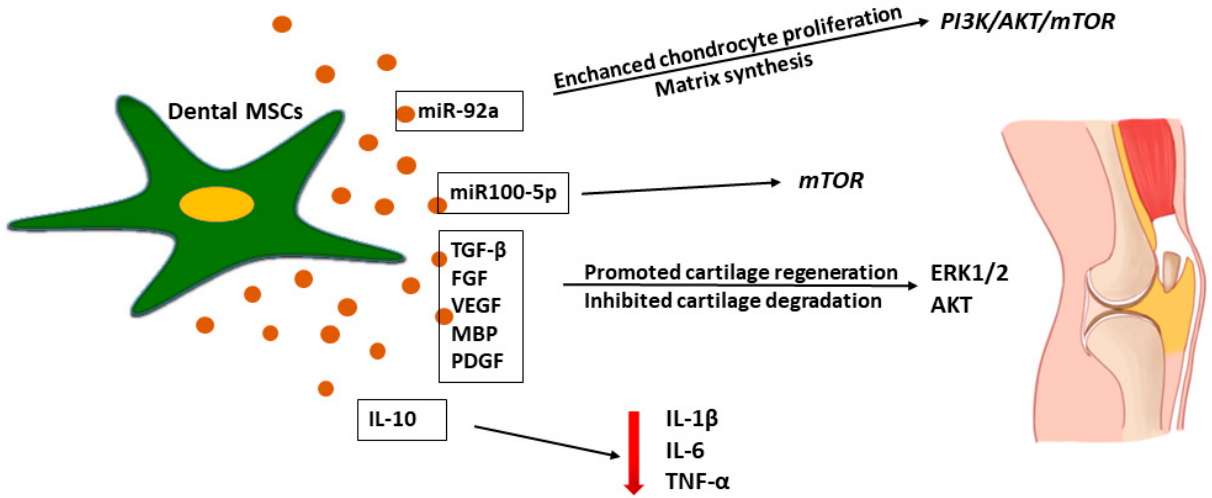
Figure 6. Effects of dental MSC-derived secretome in cartilage tissue regeneration. Dental MSC-MC inhibited inflammatory process in cartilage tissue injury by IL-10 secretion with reduced production of pro-inflammatory cytokines such as IL-1 β , IL-6, TNF- α . Dental MSC-EVs promoted cartilage regeneration by administration of miR-92 which activated Erk1/2 and Akt-driven pro-survival signal in chondrocytes that promoted their proliferation resulting in enhanced regeneration of damage cartilage tissue.